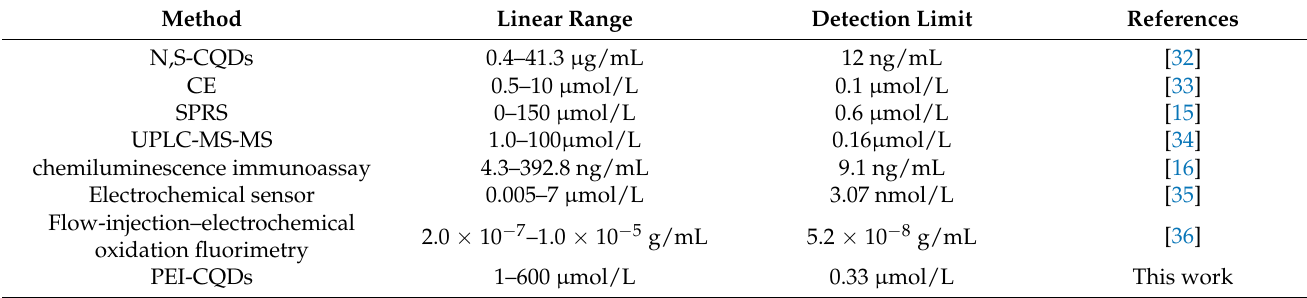
Table 1. Comparison of major characteristics for MTX with other published methods.